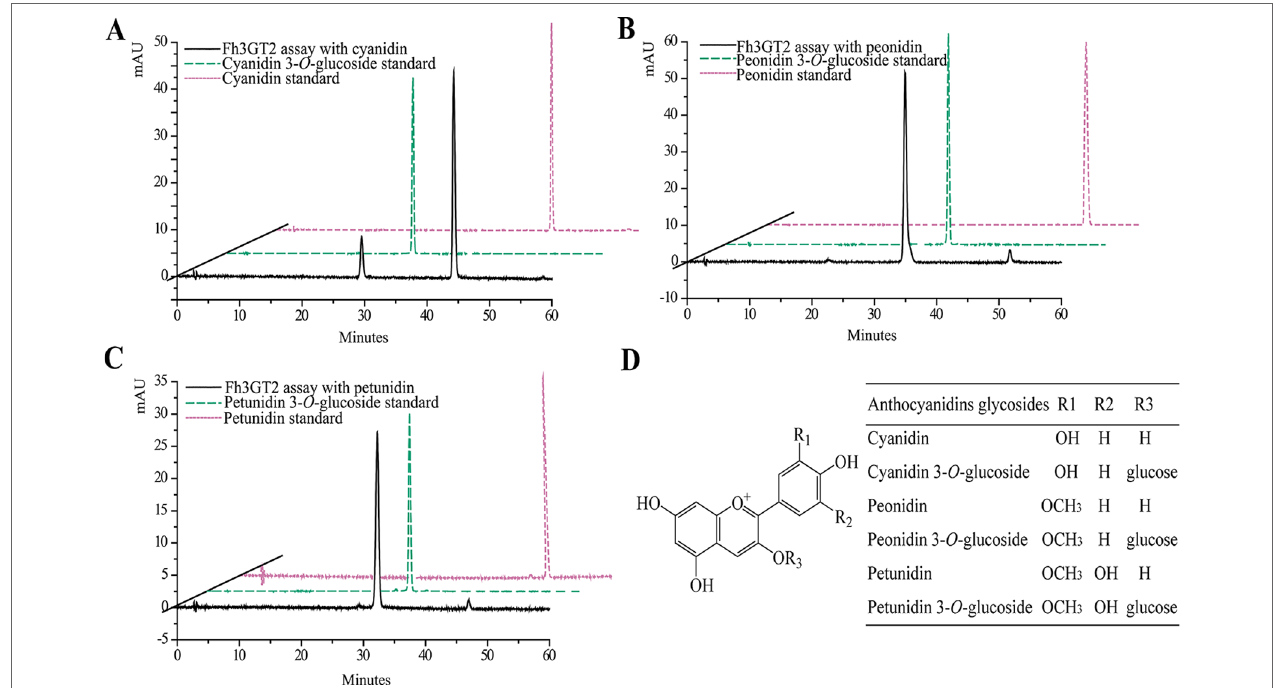
FIGURE 4 | In vitro enzyme activity assays of Fh3GT2 towards anthocyanin aglycones. (A – C) In vitro enzyme activity assays of Fh3GT2 towards cyanidin, peonidin, and petunidin, respectively. (D) Molecular structures of anthocyanin derivatives. The recombinant Fh3GT2 extracted from Escherichia coli was reacted with UDP- glucose and anthocyanin aglycones. Identification of the products was confirmed based on the standard substance and the relative retention time.